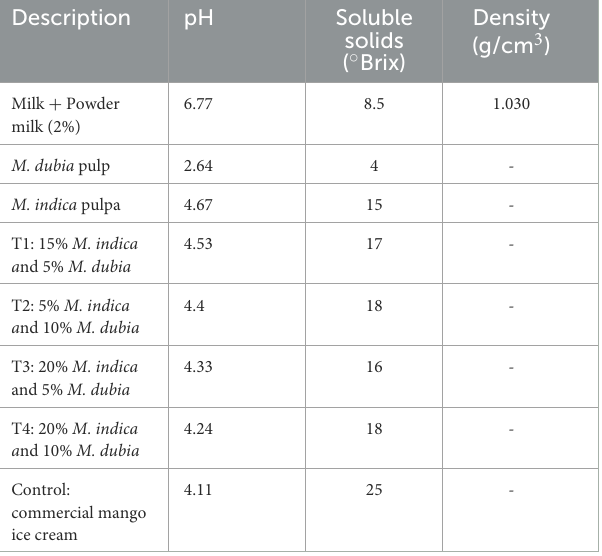
Density solids (g/cm 3 ( ◦ Brix)